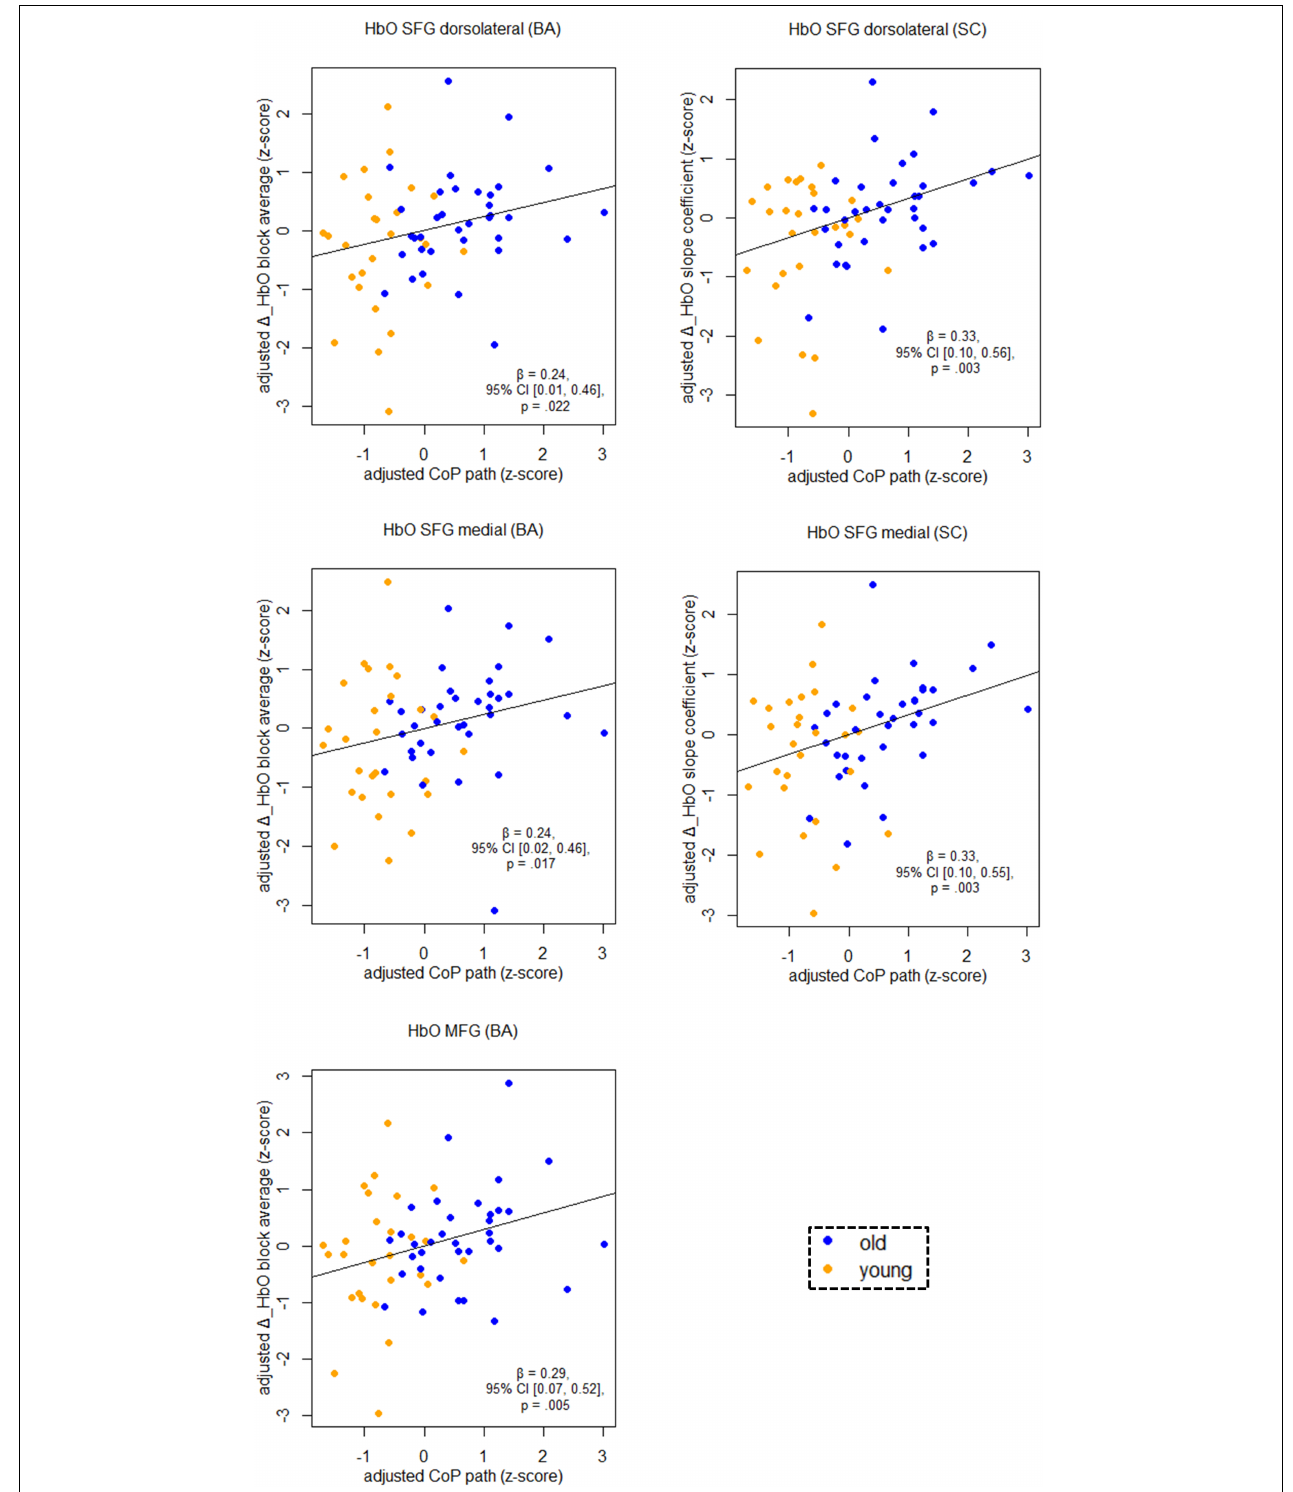
FIGURE 5 | Partial regression scatterplots with lines of best fit show the relation between balancing-induced neural activity in selected ROIs and wobble board CoP path length, corrected for the influence of sex and Baecke’s sport score. Rules of thumb for interpreting the strength of associations are | β | < 0.30 “small,” 0.30 < | β | < 0.50 “medium,” and | β | > 0.50 “large” effects, respectively (cf. Cohen, 1988). All p -values that are given in the figure are not adjusted for multiple comparisons (see Supplementary Table 3 , for FDR-corrected p -values). Abbreviations as in Figure 4 .